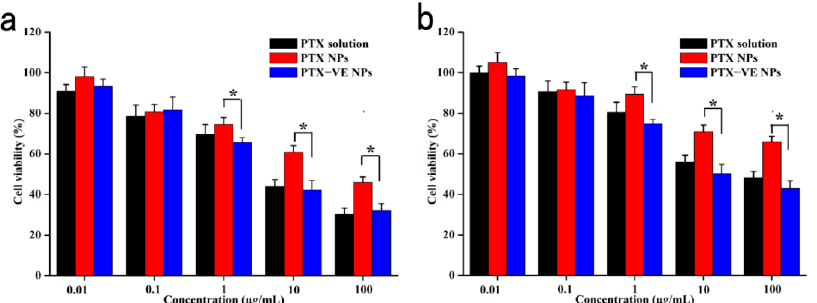
Figure 4. In vitro cytotoxicity of PTX solution, PTX NPs, and PTX-VE NPs, against MCF cells ( a ) and MCF-7/ADR cells ( b ). Data represented the mean ± S.D. (n = 3). * p < 0.05, significant difference.